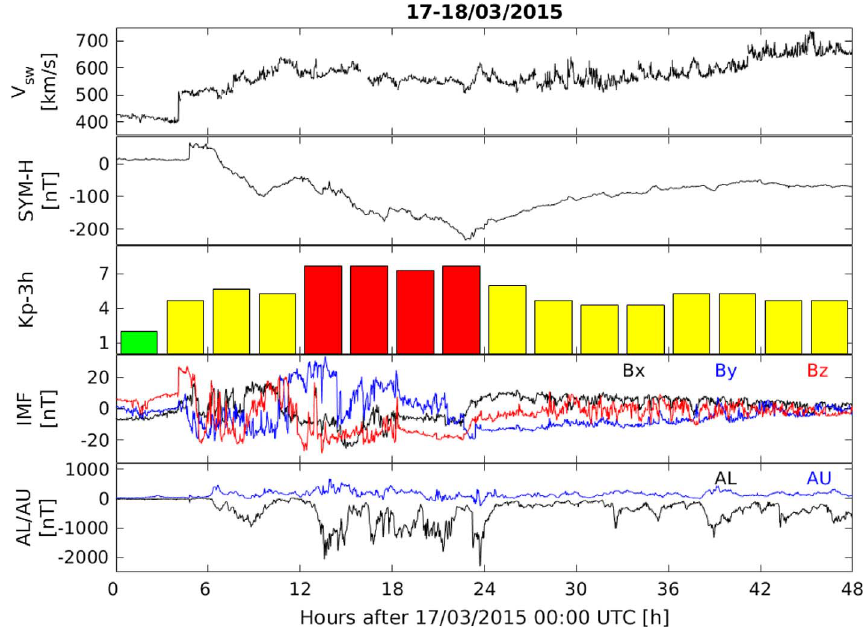
Fig. 1. Variations of solar wind, SYM-H index, three-hour K p index, three components of IMF as well as the auroral upper (AU) and lower (AL) indices on 17 – 18 March